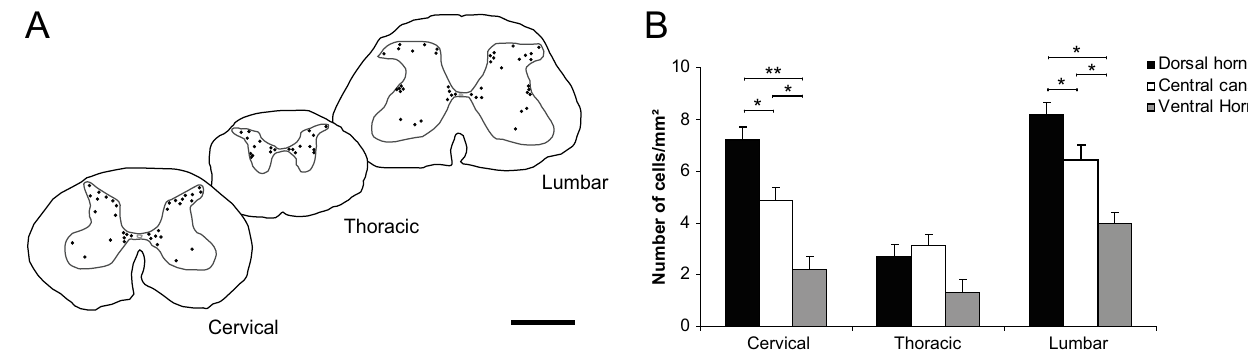
Figure 3. Distribution of NADPH-d neurons in sub-regions of the cervical, thoracic and lumbar segments of the agouti’s spinal cord. Qualitative analy- ses points to a heterogeneous distribution of NADPH-d neurons across spinal cord segments (A) , confi rmed by quantitative analysis depicted in the histogram (B) . For any given spinal segment, the number of NADPH-d cells is greater in both the dorsal horn and central canal than in the ventral horn (B) . In addition, these cells are found in greater number in both the cervical and lumbar segments (B) . Asterisks in horizontal bars indicate statistically signifi cant comparisons ( *p < 0.05; **p < 0.01; ANOVA/Newman–Keuls post hoc test). Scale bar in A: 10